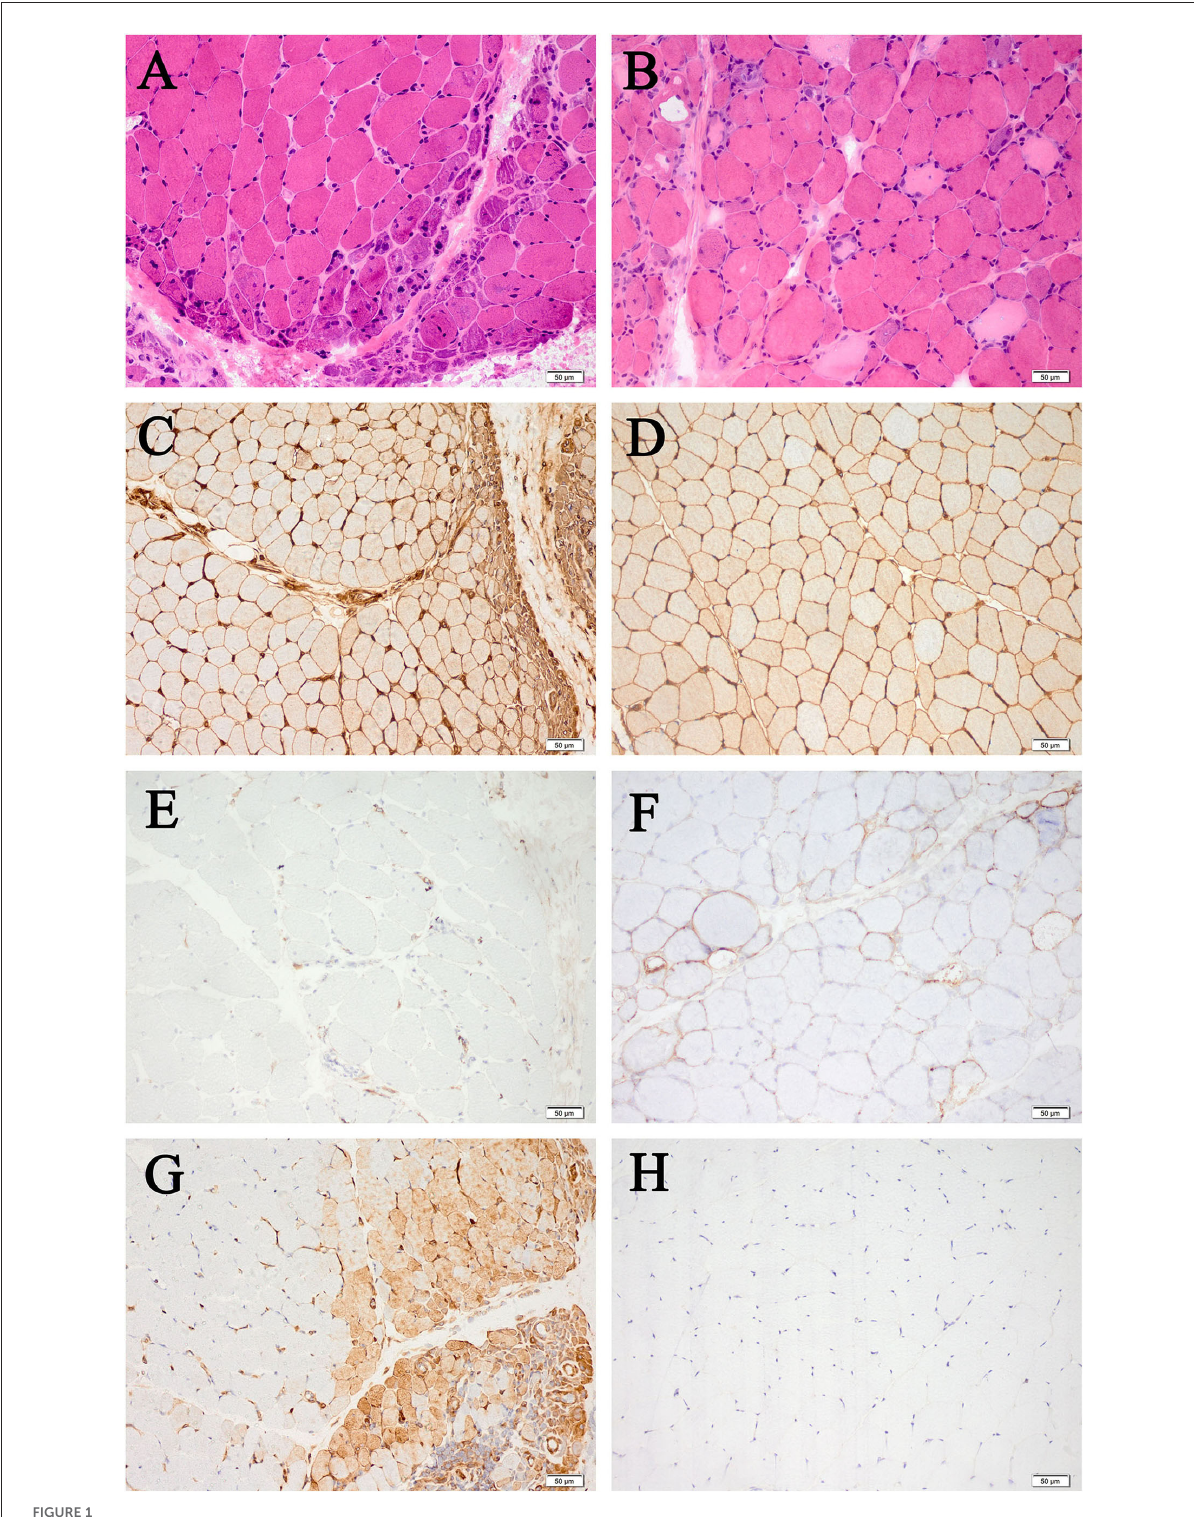
FIGURE1 Myopathological changes in patients with DM (A,C,E,G) and patients with ASS (B,D,F,H) (200 × magnification). (A) Perifascicular fiber atrophy on HE staining. (B) Perifascicular necrosis on HE staining. (C) Diffuse MHC-I upregulation, with enhancement in the perifascicular region. (D) Diffuse MHC-I upregulation. (E) MAC deposition on the endomysial capillaries. (F) Sarcolemma MAC deposition on non-necrotic fibers. (G) MxA-positive fibers. (H) MxA-negative fibers. DM, dermatomyositis; ASS, anti-synthetase syndrome; HE, hematoxylin and eosin; MHC-I, major histocompatibility complex class I; MAC, membrane attack complex; MxA, myxovirus resistance protein